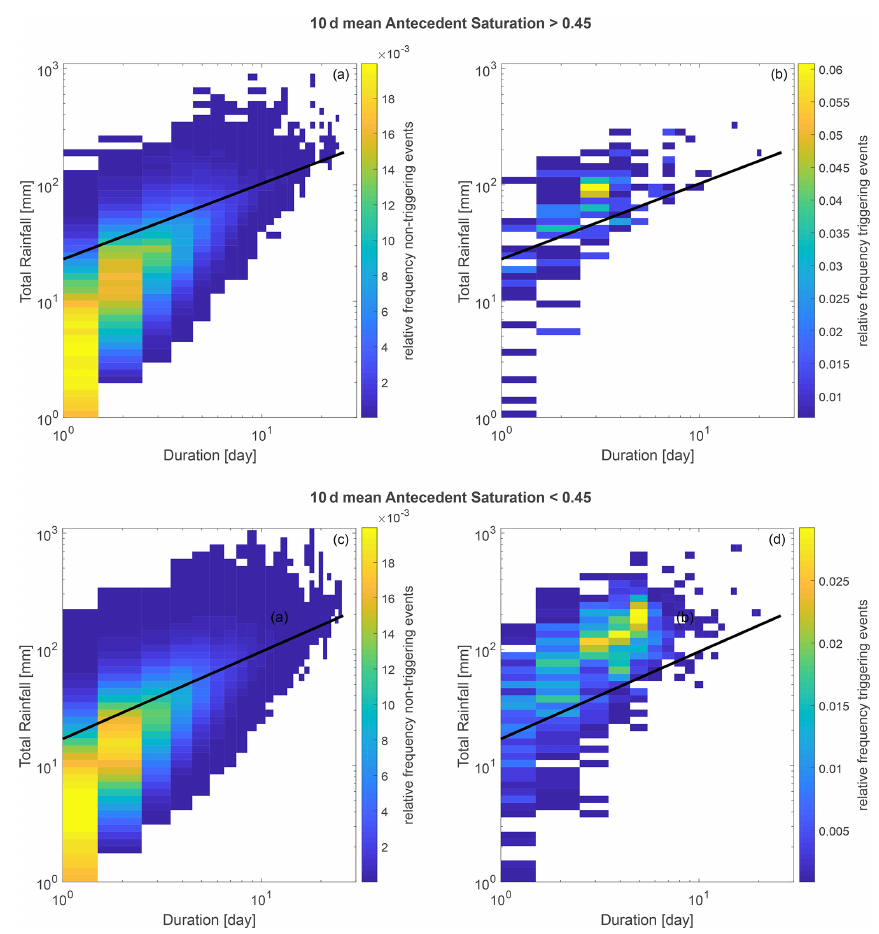
Figure 9. Relative frequency plot of triggering (b, d) and non-triggering (a, c) events for the total rainfall–duration (ED) threshold above (a, b) and below (c, d) the soil saturation threshold of 0.45. The two ED thresholds curves are indicated as black lines in the upper panels, and their equations are in the